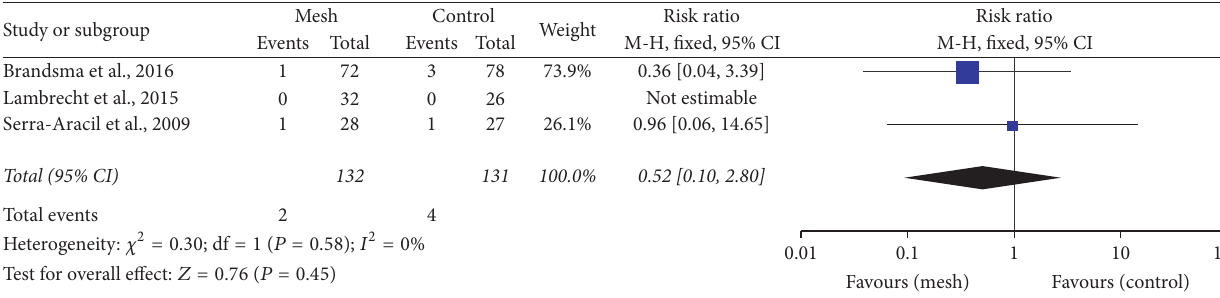
Figure 7: Forest plot for peristomal infection.